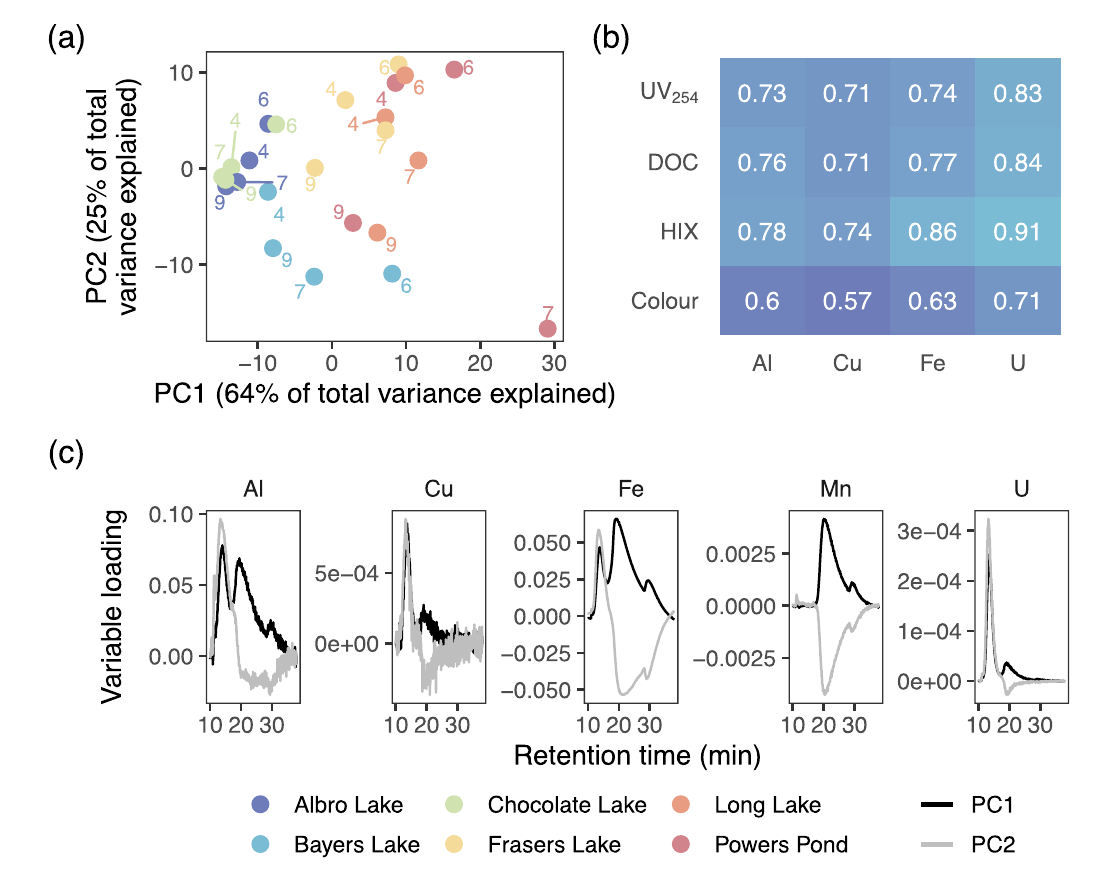
Fig. 4 Multivariate analysis of lake water chemistry. a FFF data representing all six study lakes, projected onto the space spanned by the fi rst two principal components. Sample month is annotated with Arabic numerals. b Except for manganese, semiquantitative element concentrations in the 1 kDa size fraction were correlated with UV 254 , true color, DOC, and HIX (Table 1). Values represent Spearman rank correlation coef fi cients. c Variable loadings (eigenvectors), separated by element. Data were collected in 2019 (Table